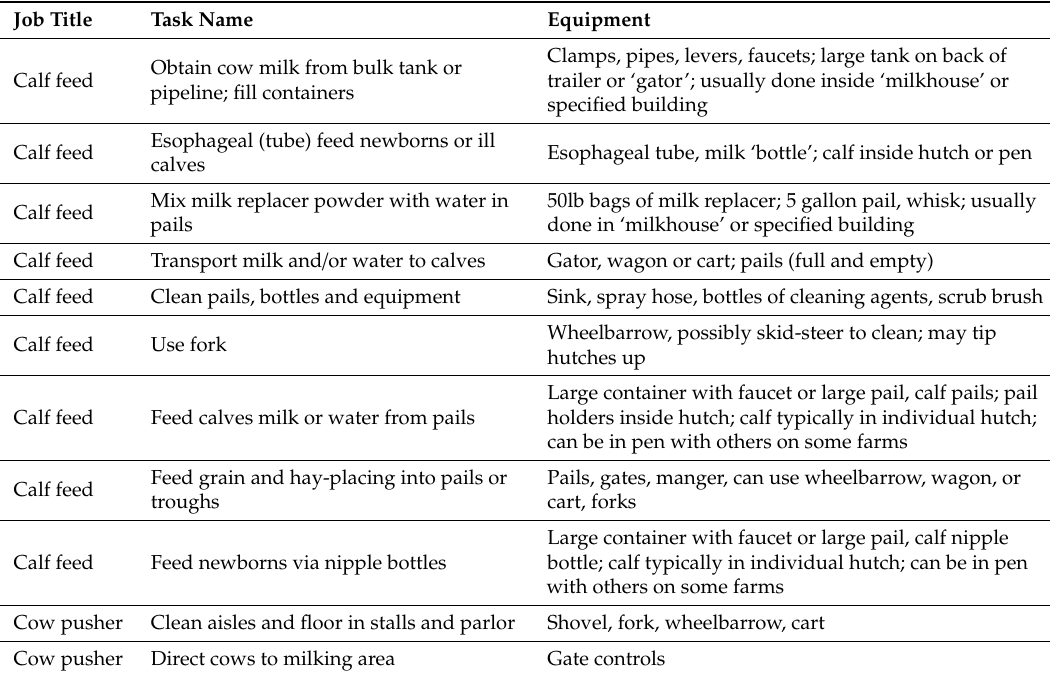
Table 1. Sample of data contained in the